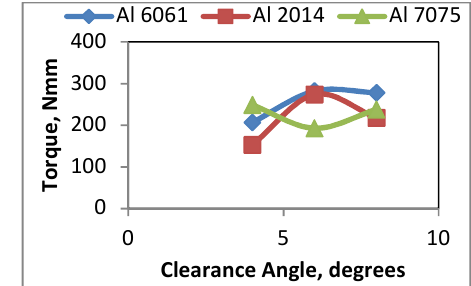
Fig. 17. Effect of variation in the clearance angle on thrust force (SET-II)